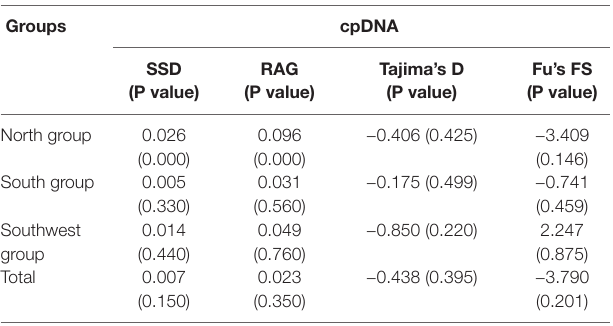
TABle 3 | Results of demographic analyses based on two datasets for three groups and all samples of Pterocarya stenoptera . Groups